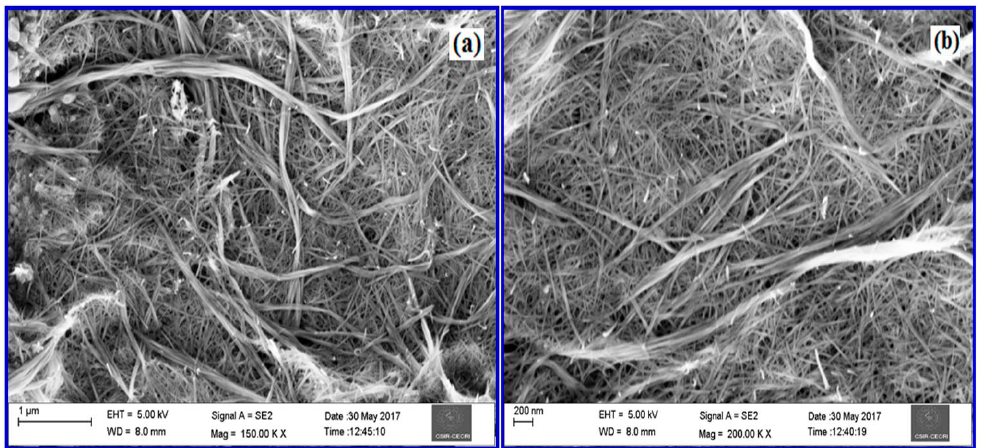
Figure 4. Field Emission-Scanning Electron Microscopy (FE-SEM) micrographs of CuO nanowires